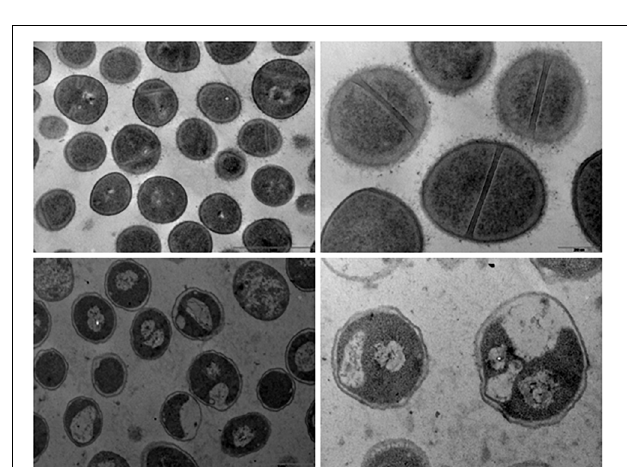
FIGURE 5 | Transmission electron micrographs. Control (above) and Fluopsin C-treated K. pneumoniae cells (below). TEM studies demonstrated that Fluopsin C induced internal cell damage.